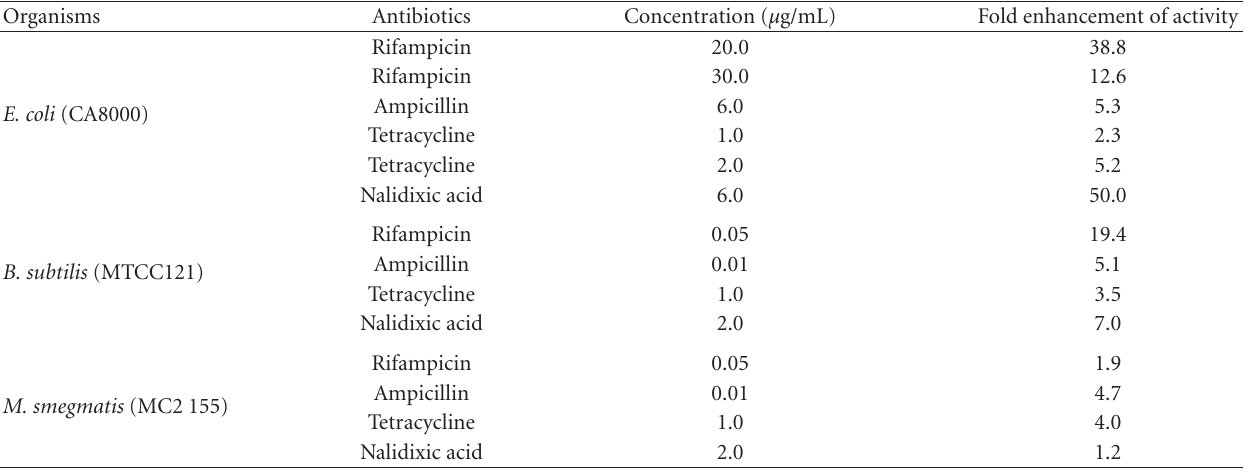
Table 21: Enhancement of antibiotic activity by niaziridin ∗ in combination with antibiotics against di ff erent organisms [145, 146]. Organisms